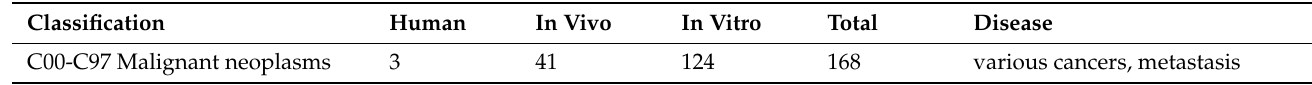
Table 4. The statistics of pharmacological results and its major diseases of SMC by experimental type in II Neoplasms of